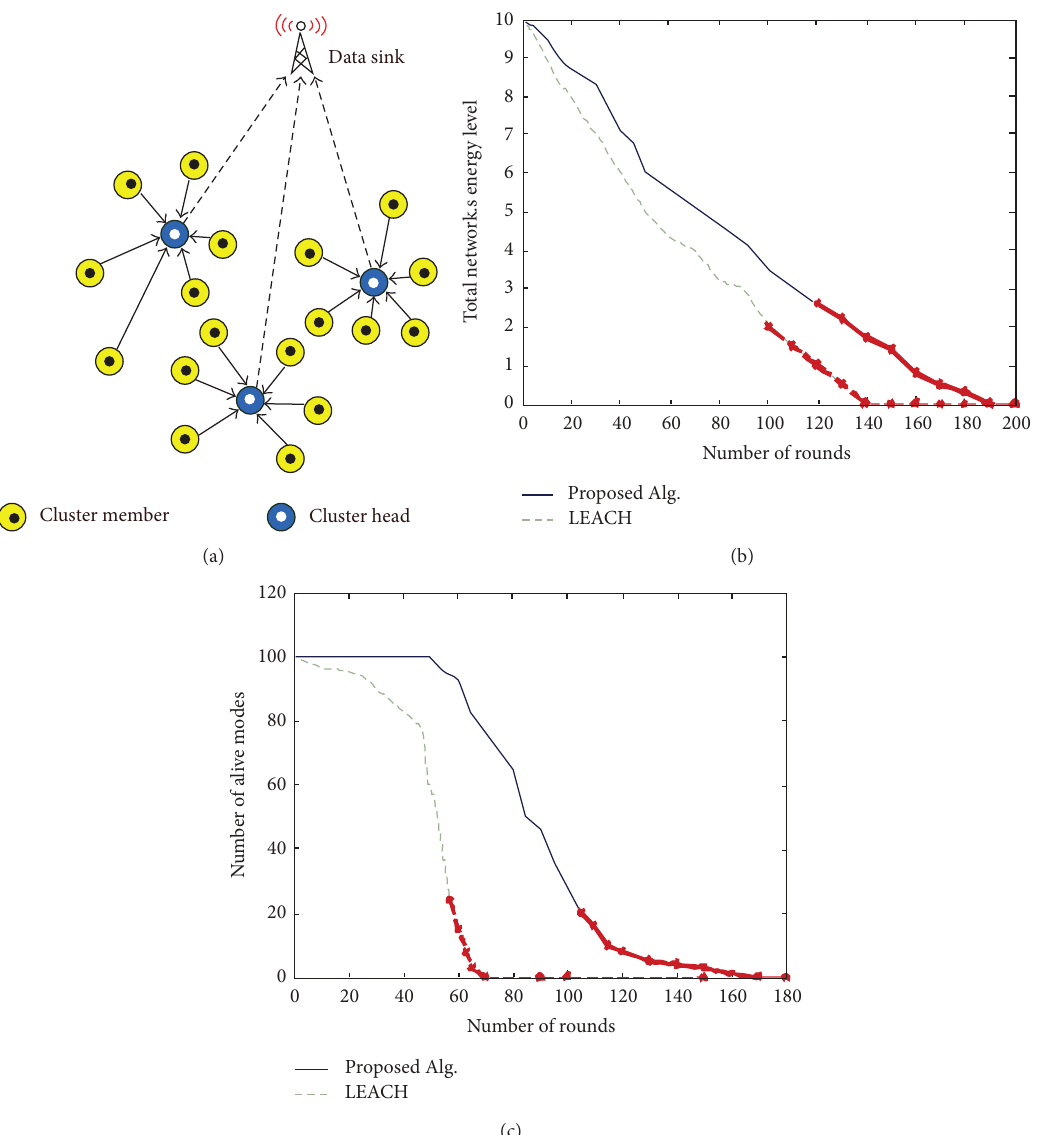
Figure 5: (a) A sample of cluster based WSN. (b) Energy consumption rate over the lifetime of a network. (c) Comparison of live nodes in two